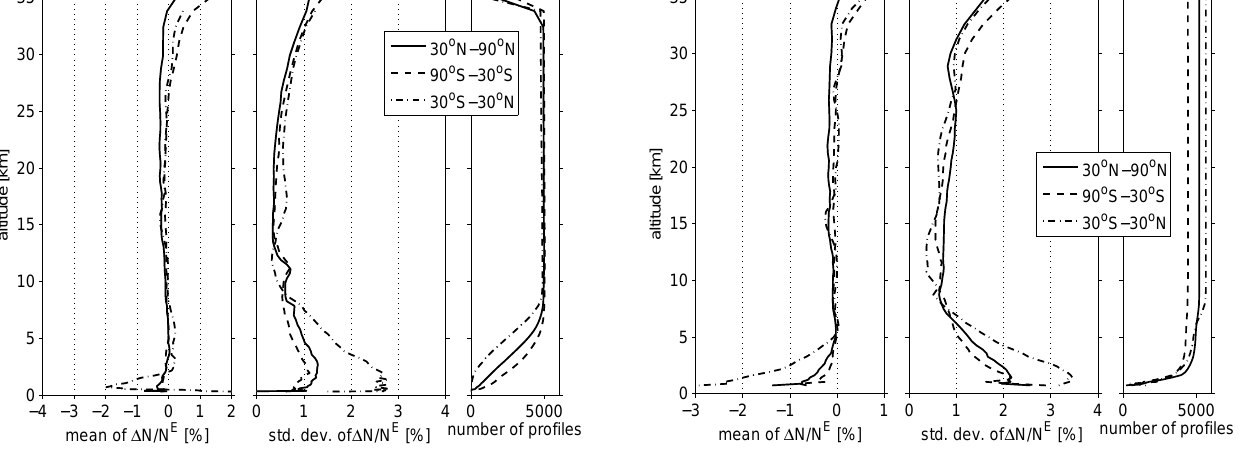
Fig. 12. Same as Fig. 11 but for 15159 GRACE-A GPSRO ob- servations recorded during the same time period and processed by GFZ’s operational processing system POCS.